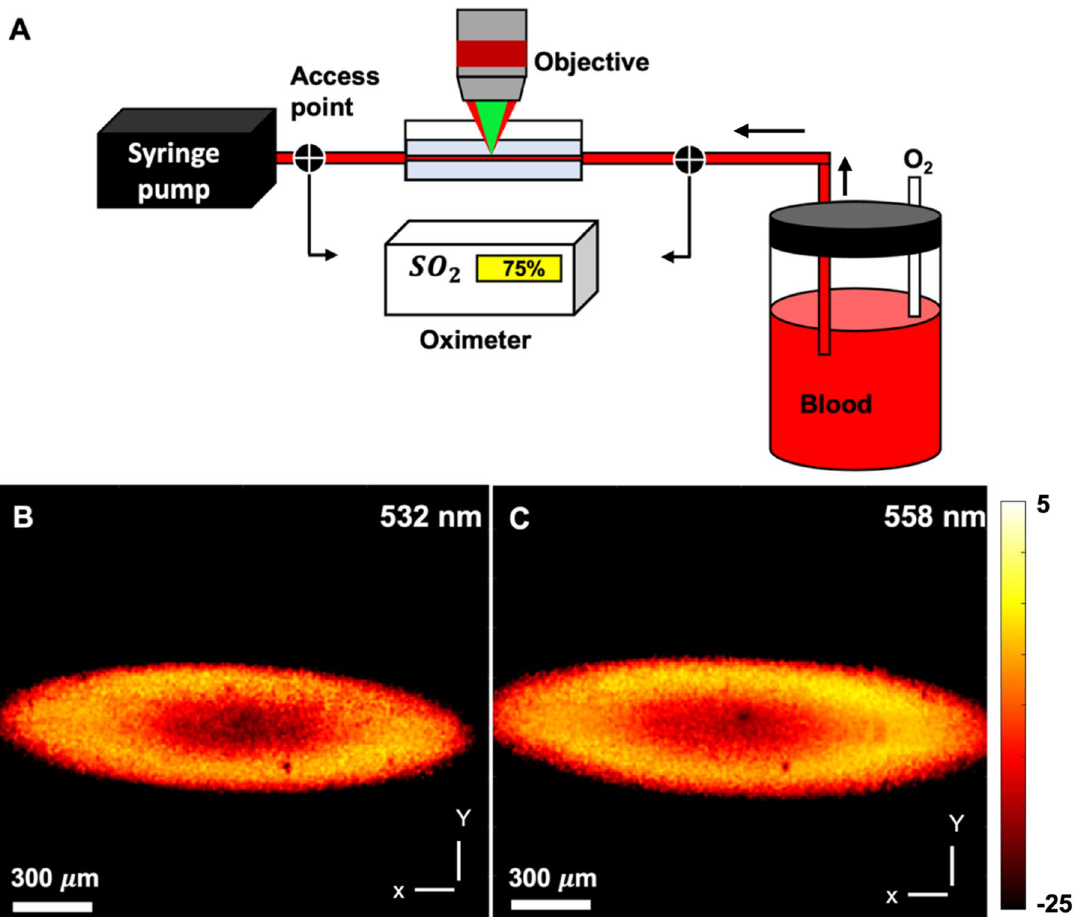
Figure 3. In-vitro bovine blood phantom experiment. Experimental setup of the experiment ( A ). Images of glass capillary with flowing blood acquired at 532 nm and 558 nm excitation wavelengths, respectively ( B , C